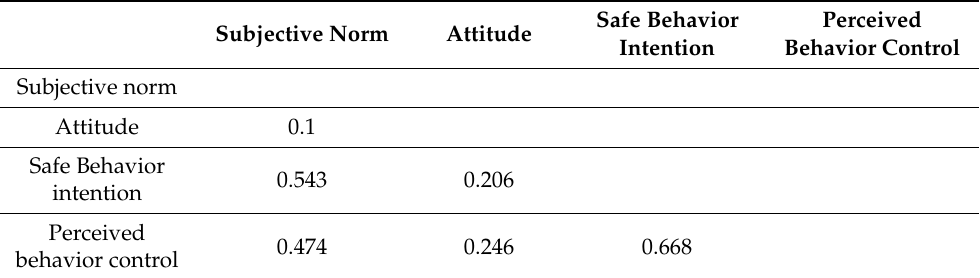
Table 3. Analysis of discriminant validity (Heterotrait-Monotrait Ratio).